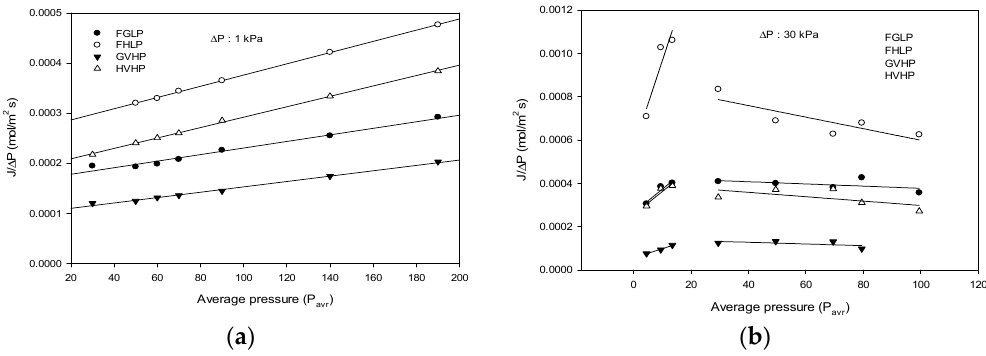
Figure 7. Dependence of J / Δ p on average pressure in gas permeability experiments. ( a ) Low Δ p ( b ) high Δ p .